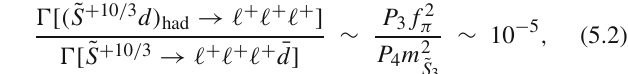
Fig. 8 N sig = 1 contours for different values of h ee in Model-1. We take m S = 3 TeV ( i = 1 , 2 , L = 30 fb − 1 and m F i